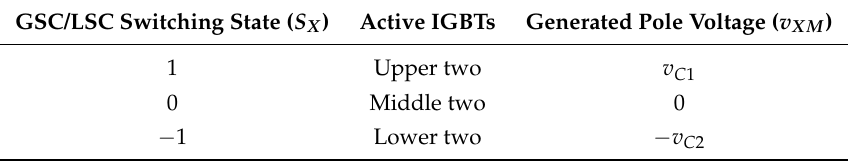
Table 1. GSC/LSC switching states in phase X